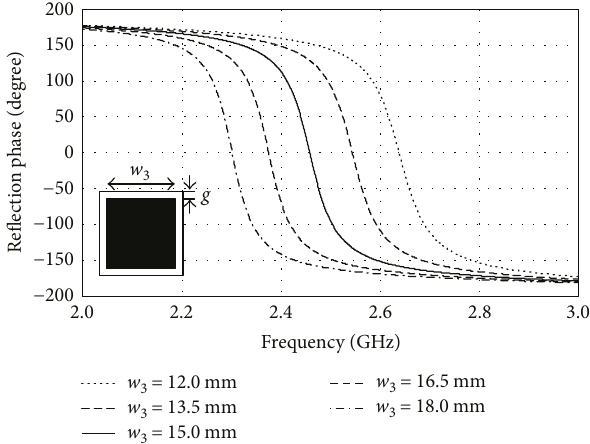
Figure 7: The simulated re fl ection phase of the HIS elemental